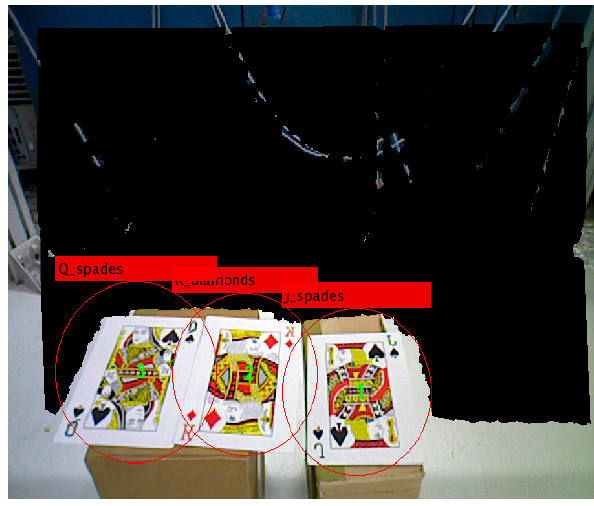
Figure 18. Label numbers on each pattern.